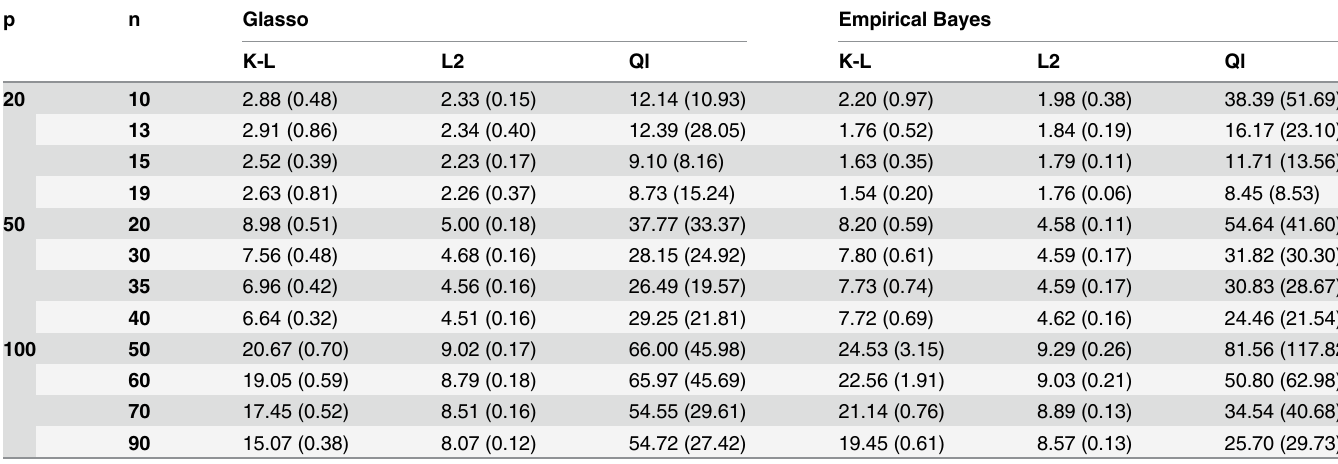
Table 1. Simulation results for different precision